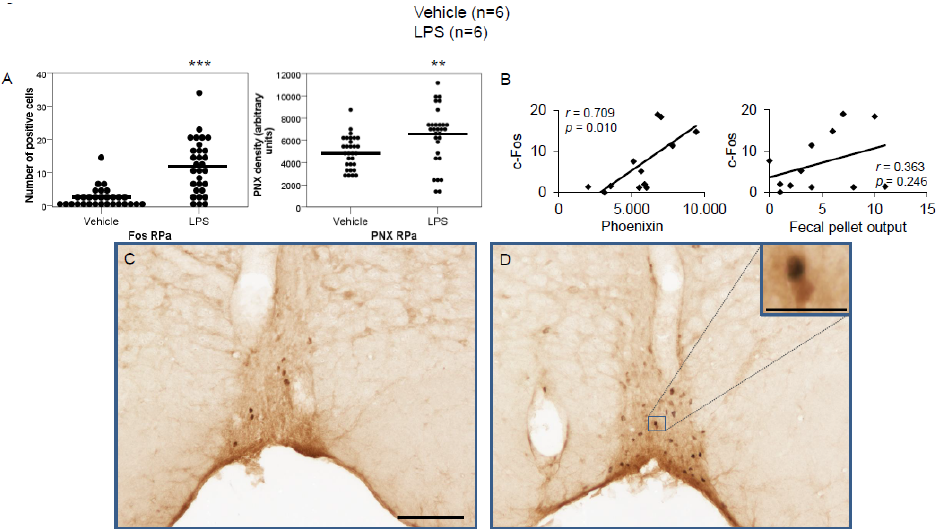
Figure 5. LPS stimulates c-Fos and phoenixin expression in the raphe pallidus. Ad libitum-fed rats were subjected to IP injection of LPS or control, and 180 min after the injection, brains were pro- cessed for c-Fos and phoenixin double-immunohistochemistry. LPS stress significantly increased